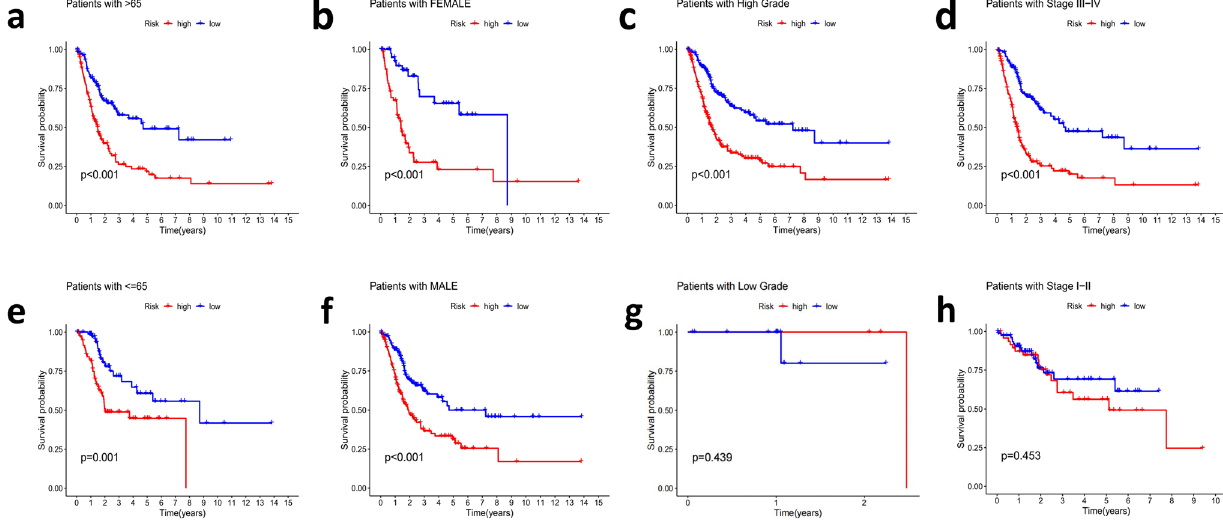
Fig. 7 The survival prediction ability of patients with different clinical characteristics of the signature a – h Stratified analyses results of age (≤ 65 and > 65), gender (female and male), grade (1–2 and 3–4), tumor stage (I–II and